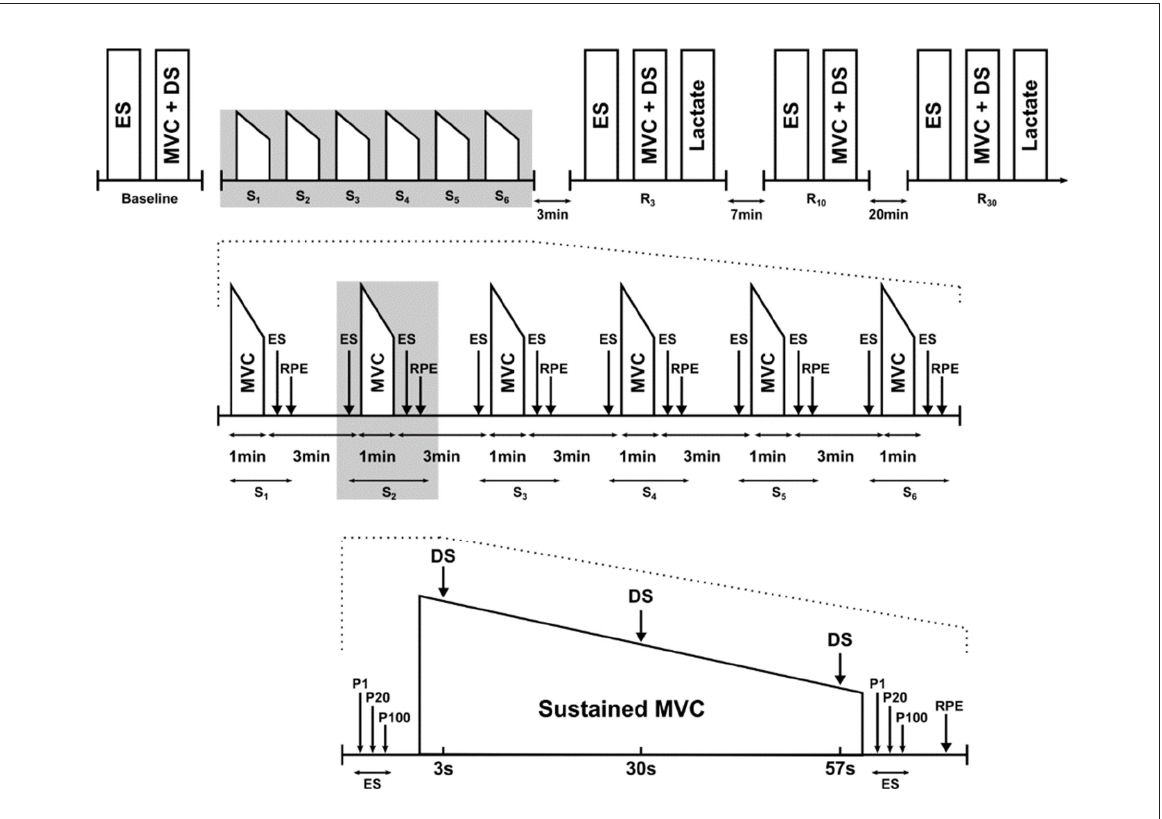
Figure 1. Experimental